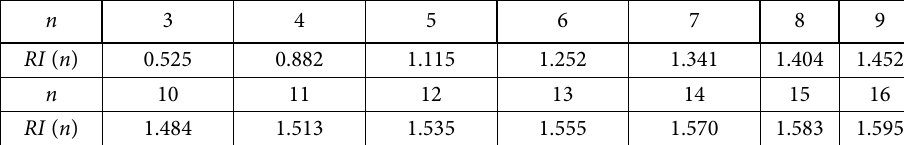
Table 2. Values of RI for 3- to 16-order PCMs by simulation